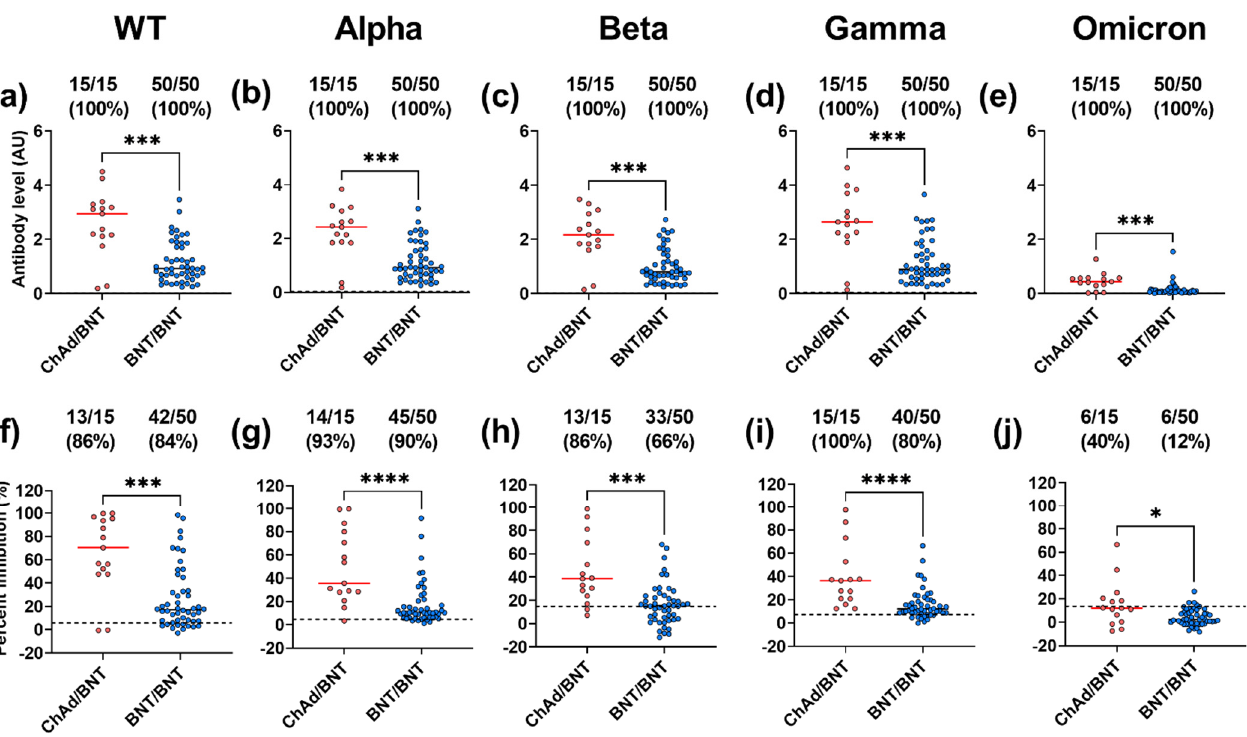
Figure 3. IgG binding and ACE2 competition in vaccine groups to SARS-CoV-2 WT and the VoCs. Levels (AU, mean with SD) of IgG ( a – e ), and ACE2 competition (percent inhibition) ( f – j ) were measured between subjects in the ChAd/BNT group (red) and those in the BNT/BNT group (blue) against SARS-CoV-2 VoC WT, Alpha, Beta, Gamma, and Omicron. A Mann–Whitney test was performed between combinations of the two vaccine groups (* p = 0.05, *** p = 0.001, **** p = 0.0001). Positivity cut-offs are represented by a dashed black line. For each vaccine group, the number of positive individuals, total number of individuals tested, and percent reactivity is shown at the top of each panel.